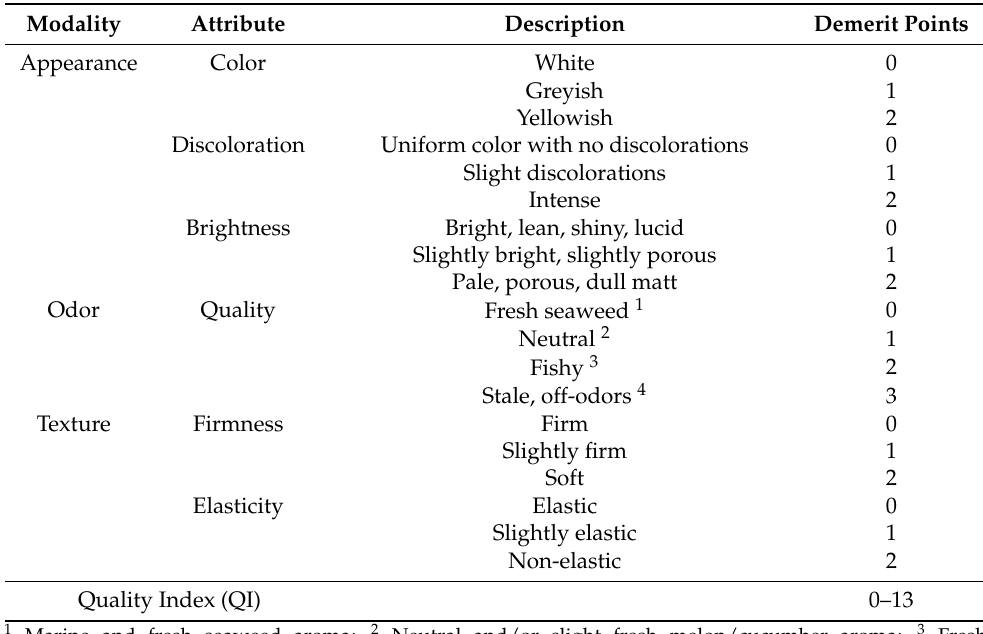
Table 1. Quality Index Method (QIM) scheme developed for the evaluation of freshness of gilthead seabream fillets. The demerit points and their corresponding descriptions are included for each attribute